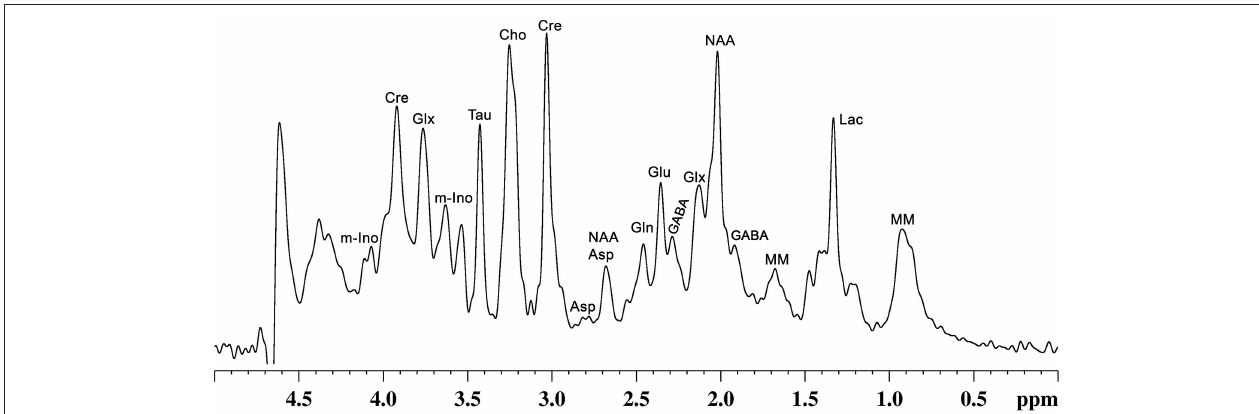
FIGURE 2 | A representative localized in vivo 1 H-NMR spectrum from mouse cerebral cortex. NMR spectrum was recorded using, a vertical wide bore magnet interfaced with 600 MHz MR spectrometer. 1 H-MR spectroscopy was carried out using STEAM method in conjunction with outer volume suppression (OVS) and water suppression (VAPOR) from a voxel (4.0 × 1.2 × 2.5 mm 3 ) with TE/TR = 4/4,000ms with 512 averaging: Peak labels are Asp, aspartate; Cho, choline; Cr, creatine; GABA, γ -aminobutyric acid; Gln, glutamine; Glu, glutamate; Glx, glutamate + glutamine; Lac, lactate; m-Ino, myo-inositol; MM, macromolecule; NAA, N-acetyl aspartate; Tau,